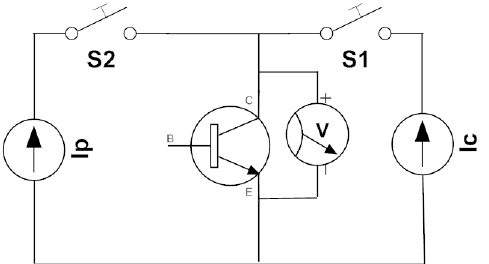
Figure 2. Circuit used in direct and thermo-sensitive electrical parameter (TSEP)-based temperature measurement.